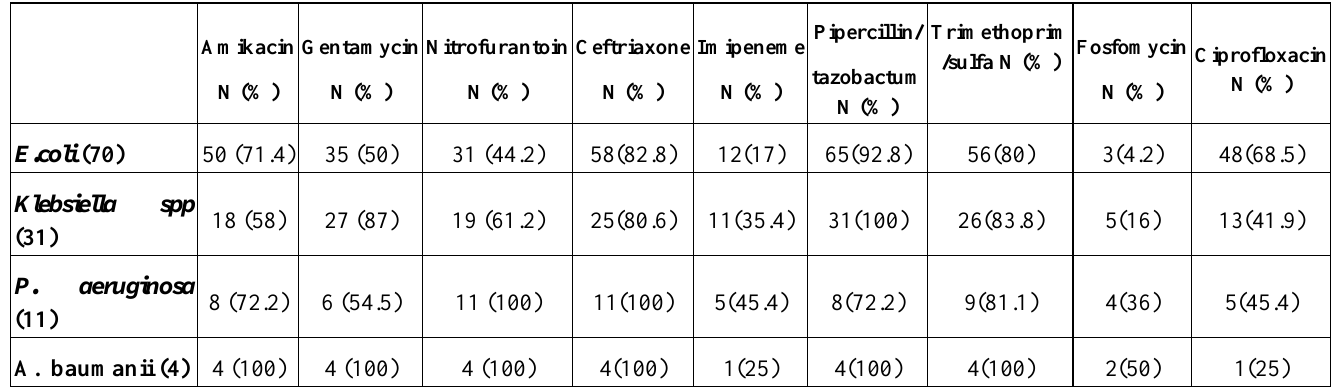
Table 1. Antimicrobial resistance profile of studied isolates.